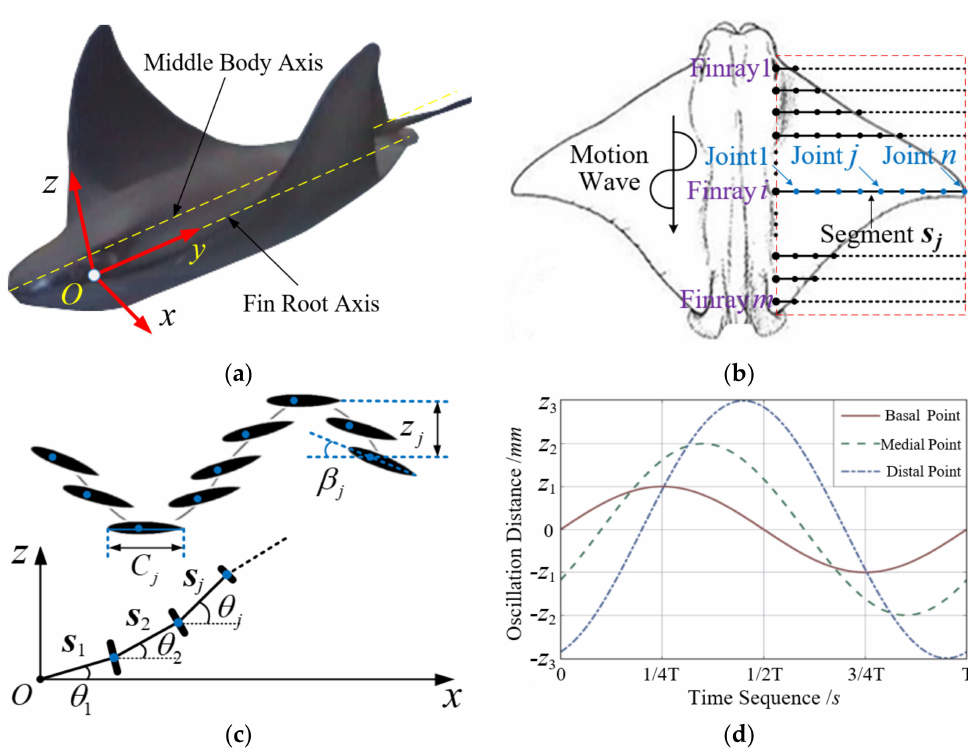
Figure 1. Kinematic model. ( a ) Coordinate system of the pectoral fin; ( b ) bionic cartilage system of the fin; ( c ) motion discretization and decoupling (flapping and pitching); ( d ) motion trajectories of different fin